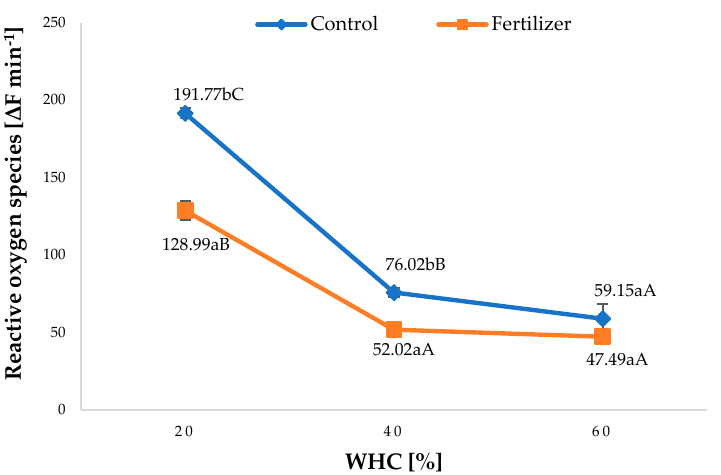
Figure 2. ROS production in maize leaves in relation to whether fertilizer was applied and to WHC [%] ( n = 20). Significant differences between the results for enhanced and non-enhanced plants growing in soils with the specific water holding capacity are marked with small letters according to the t -Test ( p < 0.05). Significant differences in the results for the various water holding capacity values are marked with capital letters according to the Tukey’s test ( p < 0.05).